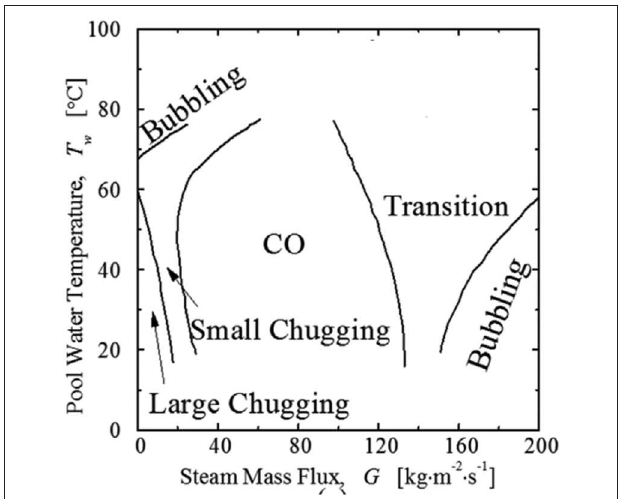
FIGURE 3 | The regime map by Aya et al. (1980, 1983) and Nariai and Aya (1986) . steam flux becomes lower. It is the boundary of the oscillatory bubble and chugging when the detachment happens just at the exit, because the steam could only exist periodically in the pool and the water would enter the pipe periodically if the steam flux becomes lower. Chan separated the chugging into three regimes with the shape and pressure oscillation: internal chug, external chug with detached bubble, and external chug with encapsulating bubble (shown in Figure 2 ).